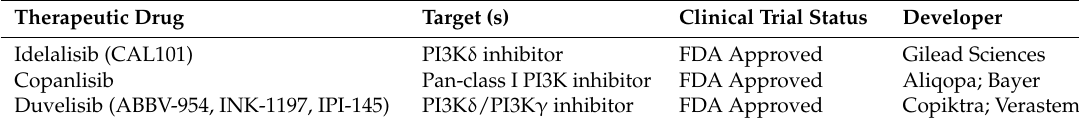
Table 2. FDA-approved PI3K inhibitors.